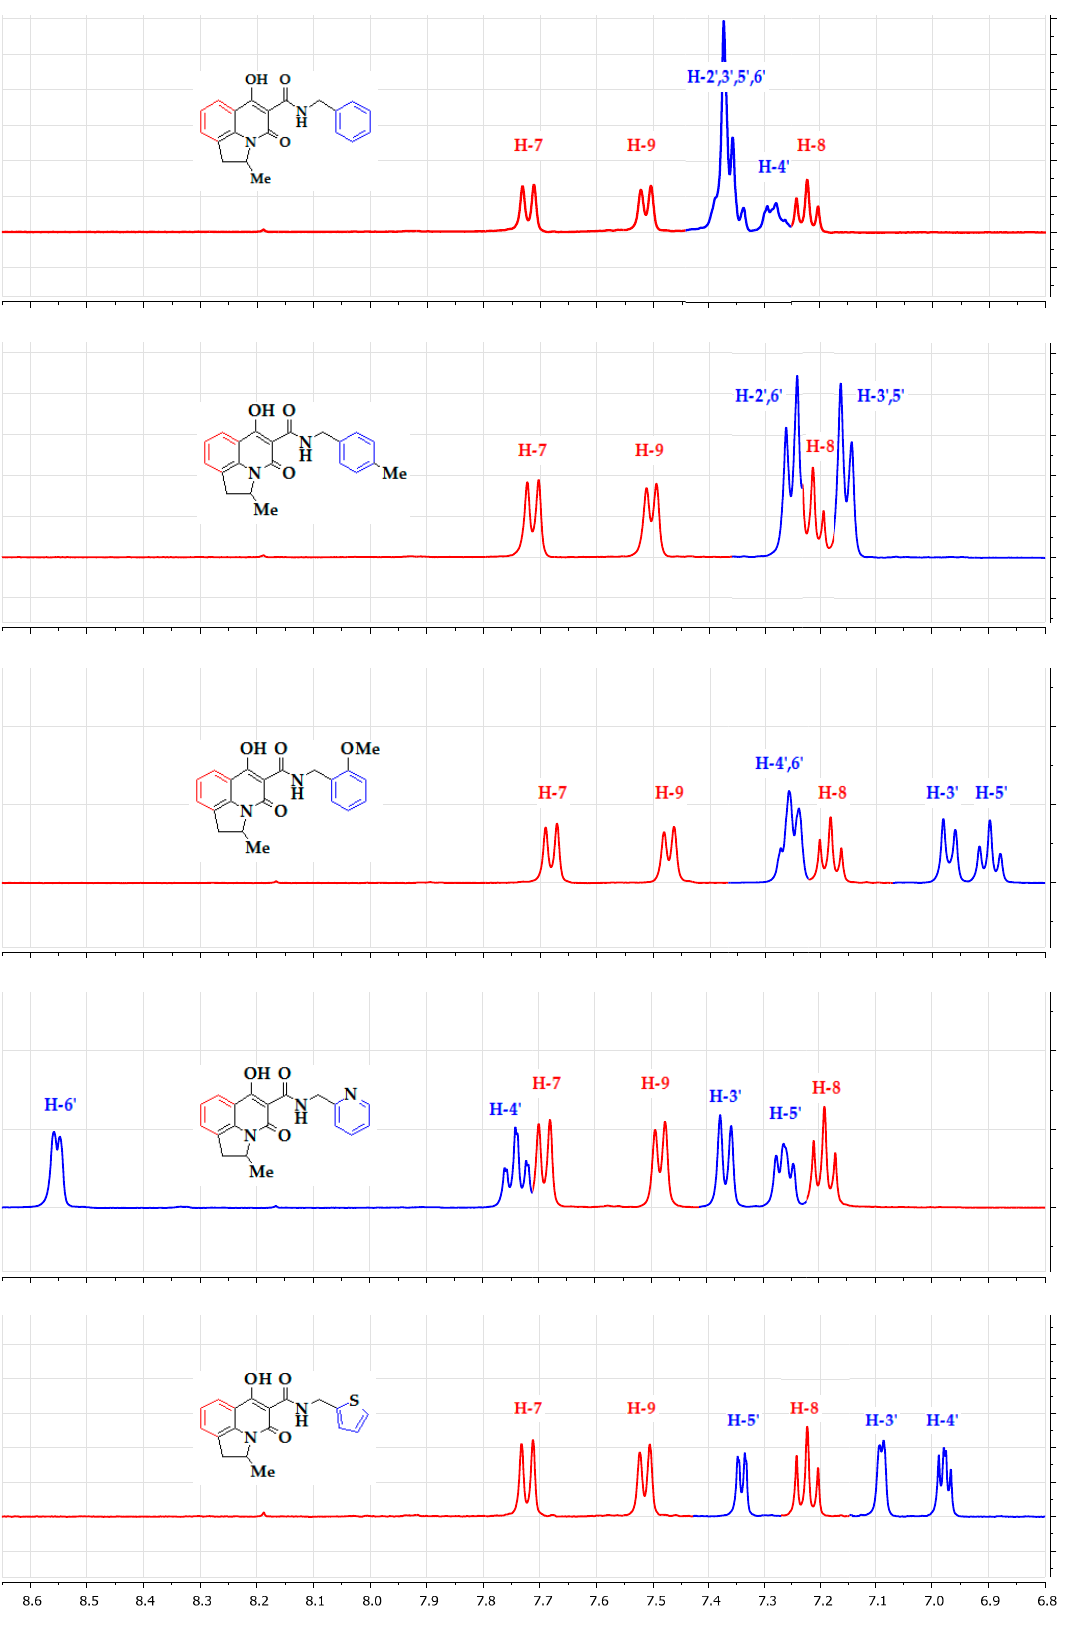
Figure 5. Fragments of the some N -(arylalkyl)amides 2 – 6 1 H-NMR spectra. The signals of aromatic protons: pyrroloquinoline ( red ) and arylalkylamide ( blue ) fragments. 13 C NMR spectra of all N -(arylalkyl)-6-hydroxy-2-methyl-4-oxo-2,4-dihydro-1 H -pyrrolo[3,2,1- ij ] quinoline-5-carboxamides 2 – 7 allow for reliably identifying the signals of only some carbon atoms of